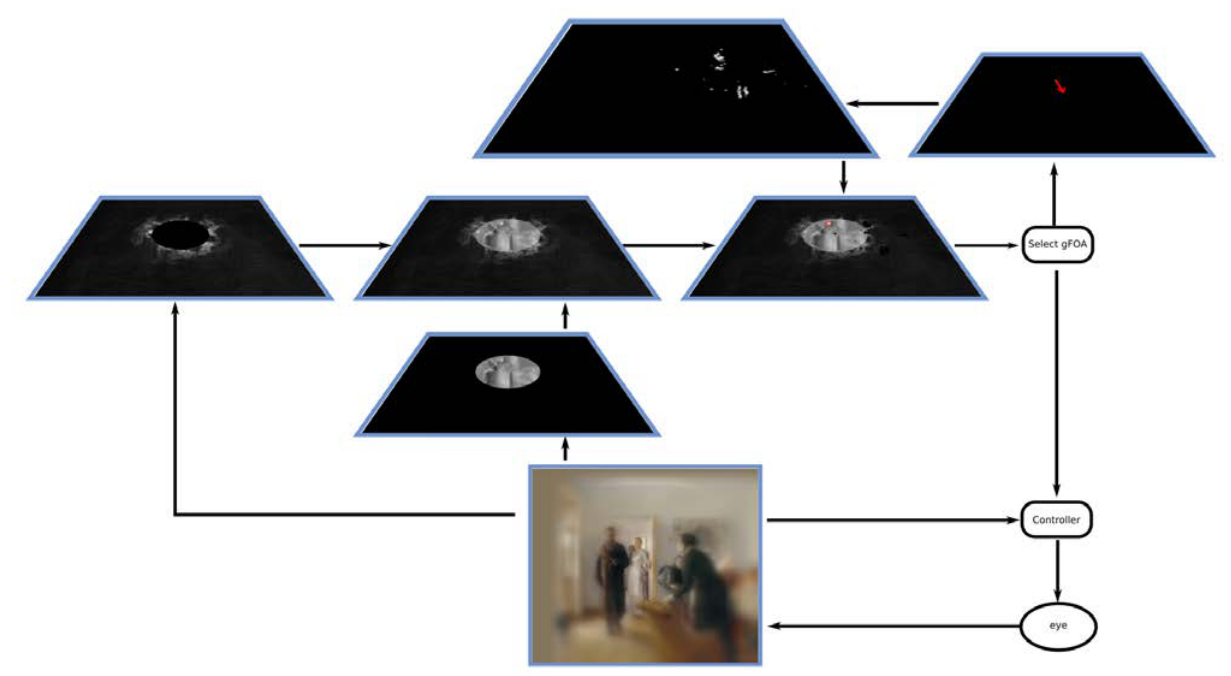
Figure 19. A snapshot of the contents of the representations STAR uses for fixation control. The representations are placed in the same position as in Figure 10 to enable quick identification. This is the computation of the 284th fixation of the scanpath in Figure 16 and in the accompanying video. The peripheral attention map shows the result of the AIM algorithm on the periphery of the visu- al field. The central attention map shows the results of the template matching. The two are combined in the conspicuity map. The priority map has the interesting representation of the modulated conspicuity map, with the modulation coming from the fixation history map. The small red oval on the priority map denotes the selected global focus of attention (gFOA). The receptive field re- mapping is shown in the top right corner representation, with the update vector that is applied to all positions of the fixation history map shown in red. Note that the computation of each representation includes a normalization component, and this explains why the ranges of gray scales across the representations vary. The accompanying video shows a sequence of several fixation computations (fixations 283 - 293) where the changes in each map from fixation to fixation can be